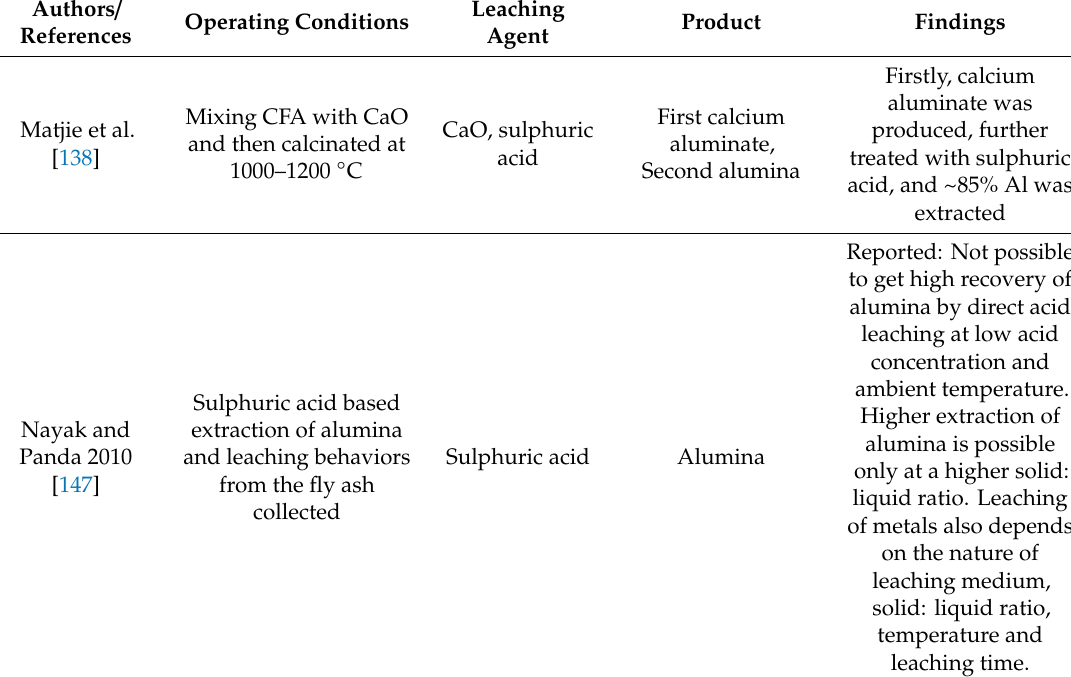
Table 4. Alumina extraction from fly ash by acid-based